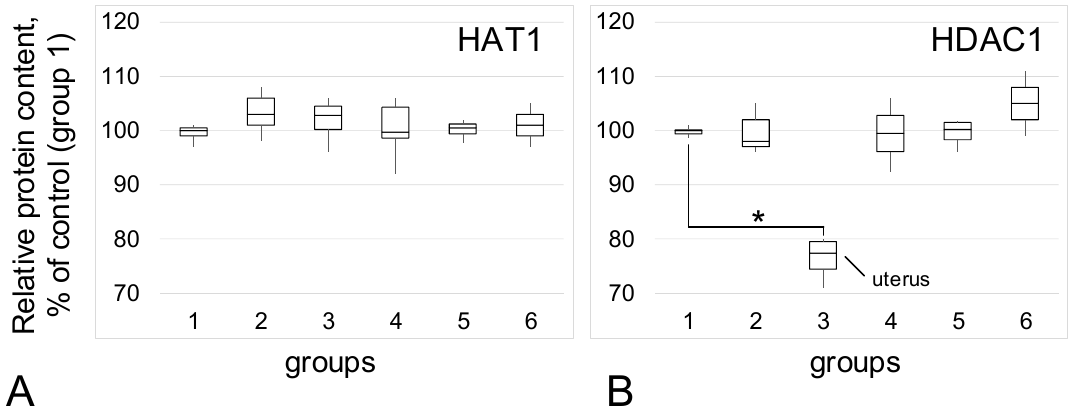
Figure 5. Acetylase/deacetylase relative content. ( A )—Histone acetylase HAT1 relative content. ( B )—Histone deacetylase HDAC1 relative content. *— p < 0.05 in comparison with control group 1 (women in postmenopause without endometriosis in their anamnesis). Group designations are the same as above.